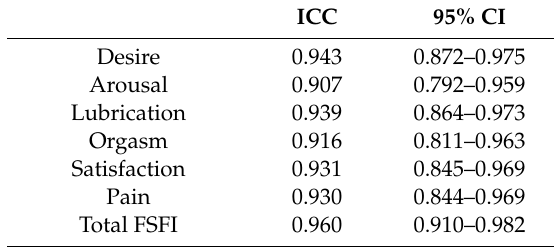
Table 2. Test-retest reliability for dimensions and total Female Sexual Function Index (FSFI) (N = 31). ICC 95% CI